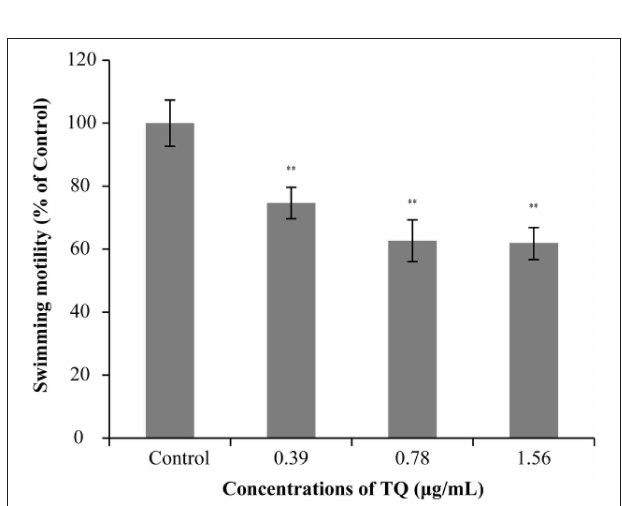
FIGURE 2 | Effect of thymoquinone (TQ) on swimming motility of Listeria monocytogenes ATCC 19115. Percentage of the size of the swimming area relative to the control group is presented as the mean ± the standard deviation of three independent experiments. Bars indicate the standard deviation ( n = 3). ** P <